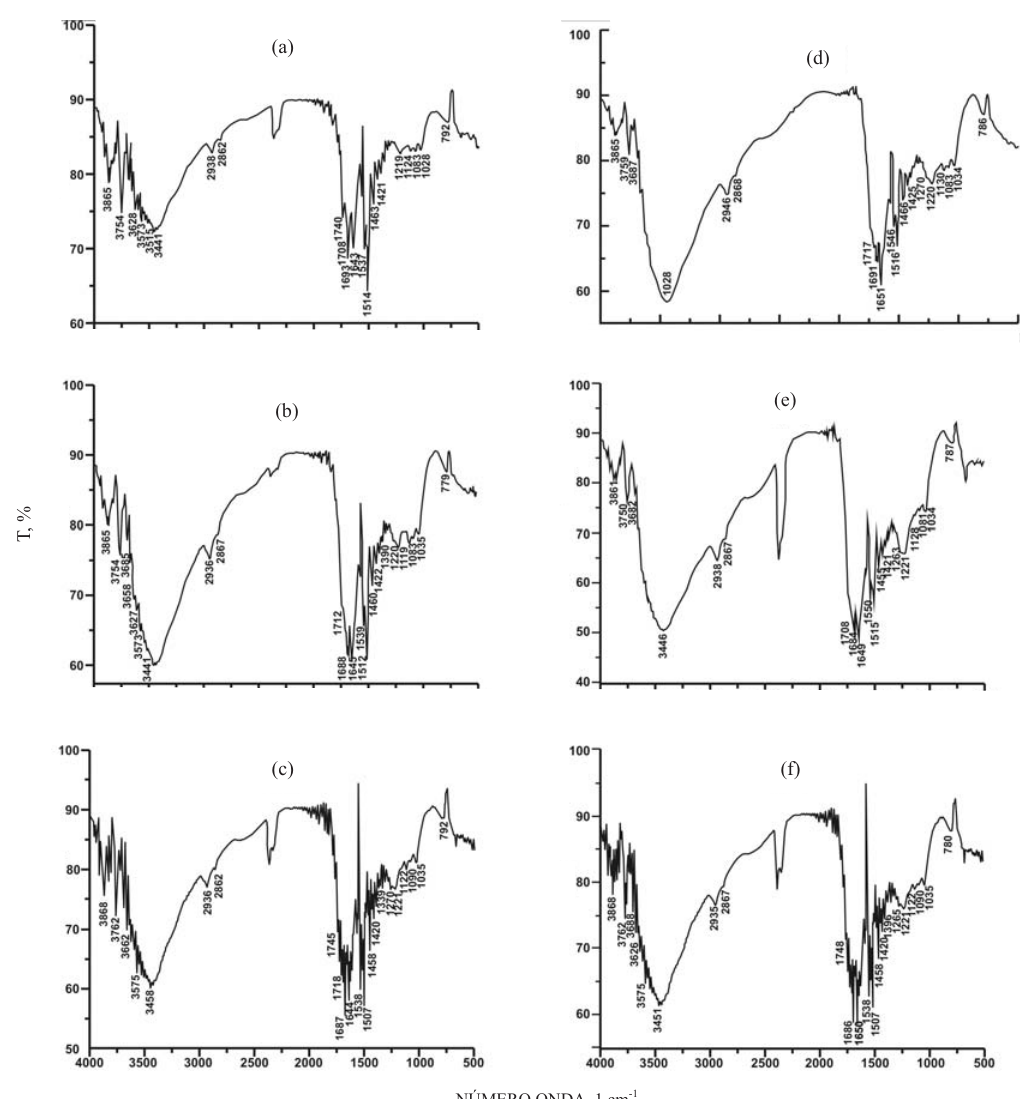
Figura 2. Espectros de infravermelho dos ácidos húmicos extraídos das amostras de solos coletadas em área de extração de argila com cobertura de Brachiaria mutica nas profundidades de 0–10 cm (a), 10–20 cm (b), 20–30 cm (c) e com Acacia mangium nas profundidades de 0–10 cm (d), 10–20 cm (e), 20–30 cm